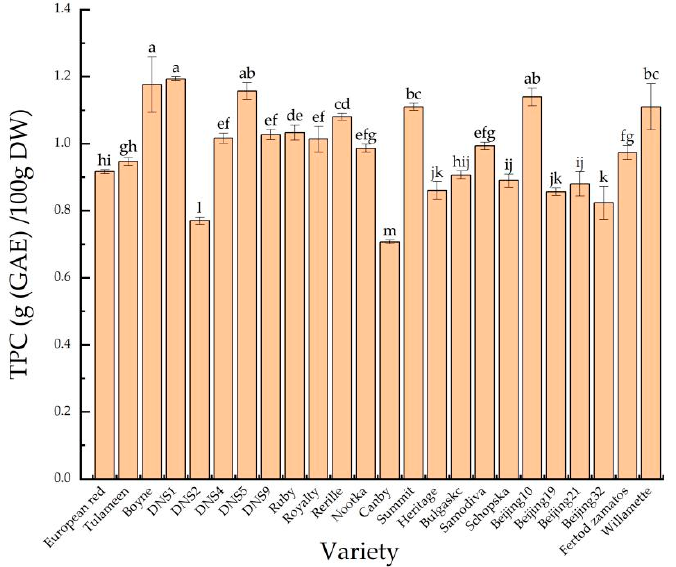
Figure 4. The total phenol contents (TPC) of 24 red raspberry varieties. Values are given as the mean ± standard deviation ( n = 3), and the different letters were significantly different ( p < 0.05).